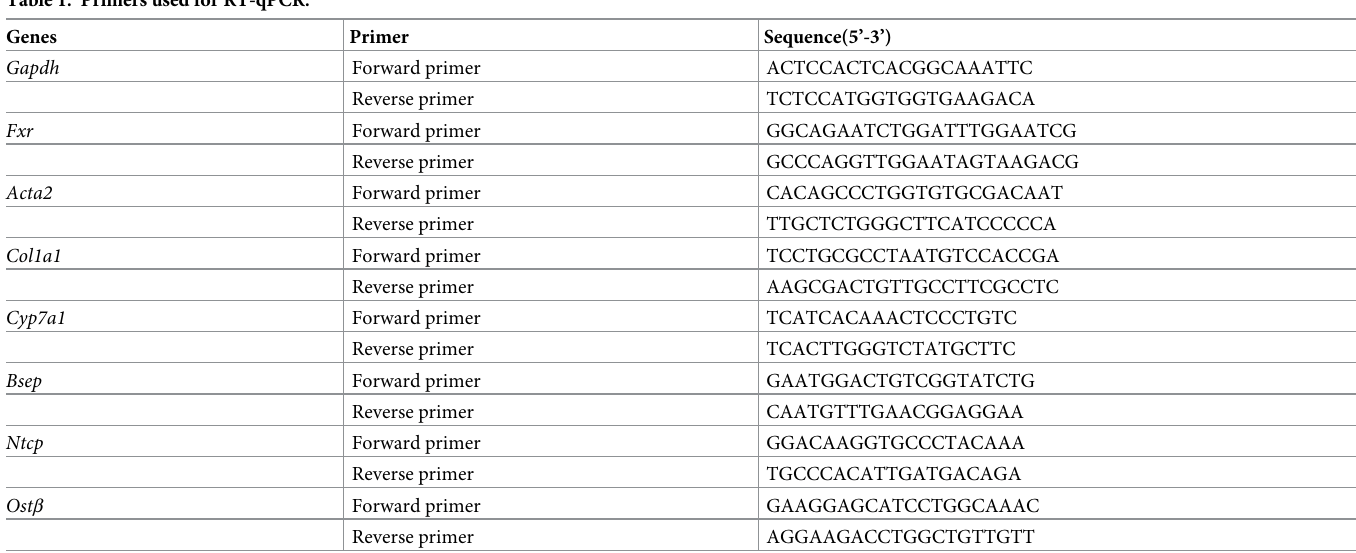
Table 1. Primers used for